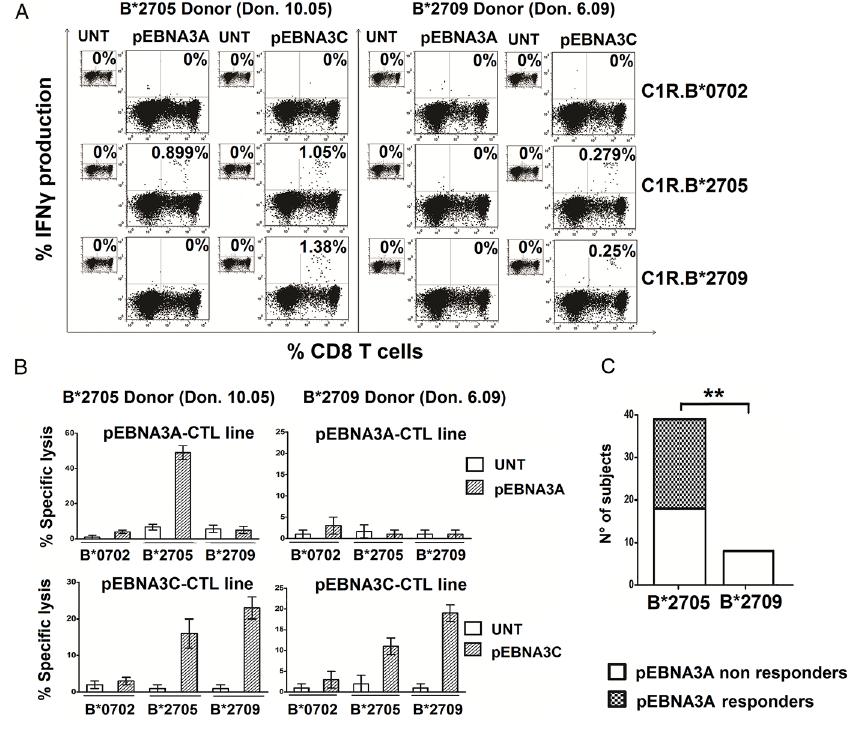
Figure 3. B*2705 but not B*2709-positive carriers react toward the HLA-B*0702-restricted EBNA3A epitope. (A) Detection of intracellular IFN γ production by PBMCs from a B*2705 positive/B*07 negative subject (Don 10.05) (left) or a B*2709 positive/B*07 negative sub- ject (Don 6.09) (right) activated with pEBNA3A or pEBNA3C peptide for 14 d and then re-stimulated by the indicated, untreated or peptide-pulsed C1R transfectants. Numbers represent the percentage of IFN γ -producing CD8 + T cells. (B) Cytotoxic activity by rep- resentative pEBNA3A- (top) and pEBNA3C- (bottom) stimulated CTL lines from the same individuals as in (A) toward C1R transfectants used as target cells. E/T ratio was 20:1. Bars represent the mean percentage of specific lysis ± SEM of three separate experiments. (C) CD8 + T cell responses to EBNA3A detected by IFN γ production analyzed in 38 B*2705 carriers (31 patients with AS and 7 healthy controls) and in 8 B*2709 healthy donors. Twen- ty-one out of 38 B*2705 and no subject out of 8 B*2709 individuals show reactivity against EBNA3A antigen ( p value = 0.0049 calculated by Fisher’s two-tailed exact